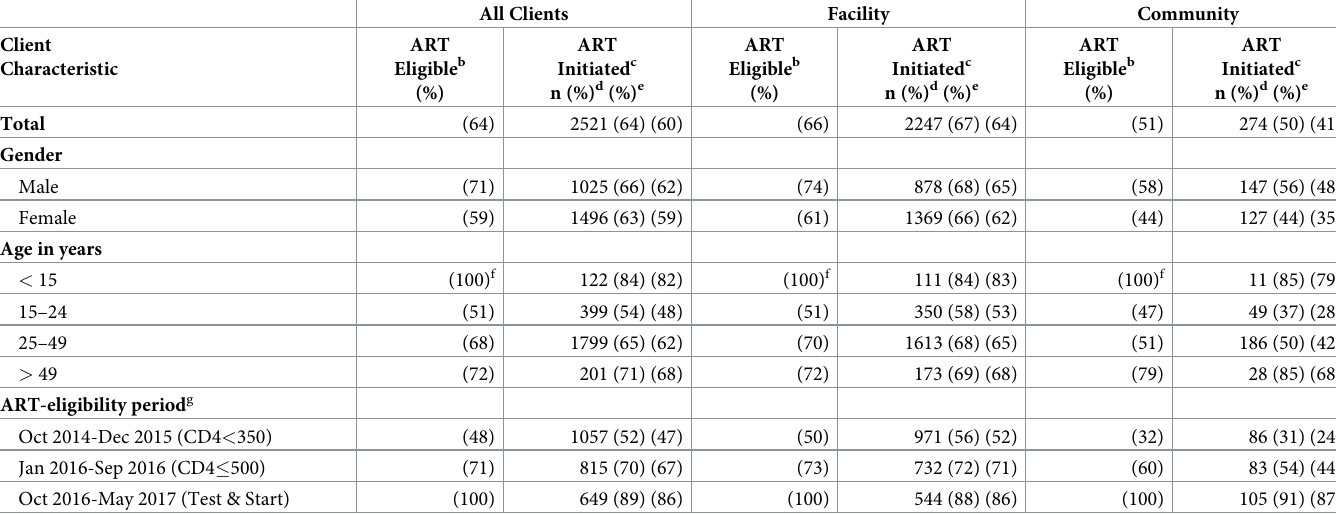
Table 4. ART initiation within 90 days of LCM program consent, by setting of HIV diagnosis and client characteristics, Bukoba Combination Prevention Evalua- tion, Bukoba Tanzania, 2014–2017. a . All